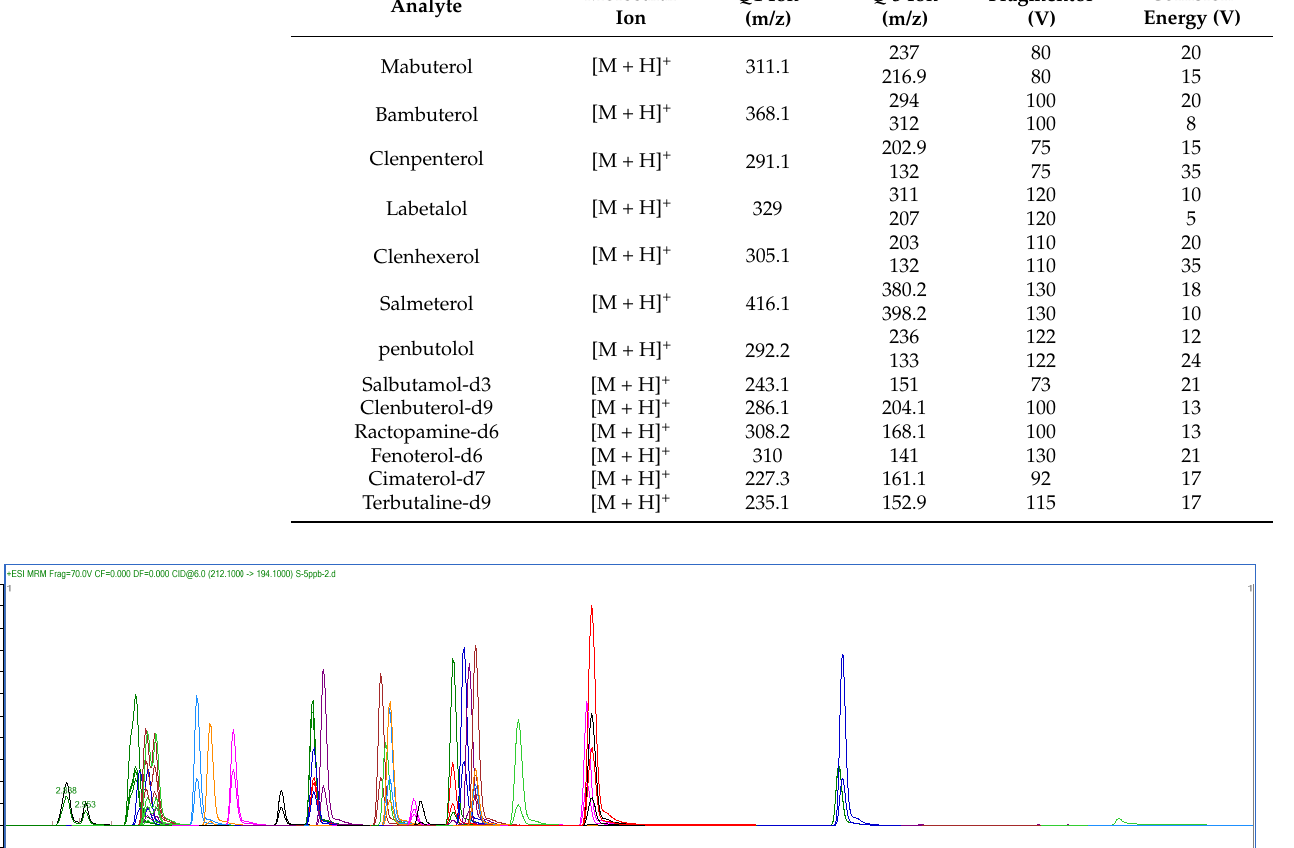
Figure 1. Total ion chromatogram (TIC) of the fortified swine muscle-based sample. Concentration levels: 5 μ g/L of 26 beta-agonists and ISs.